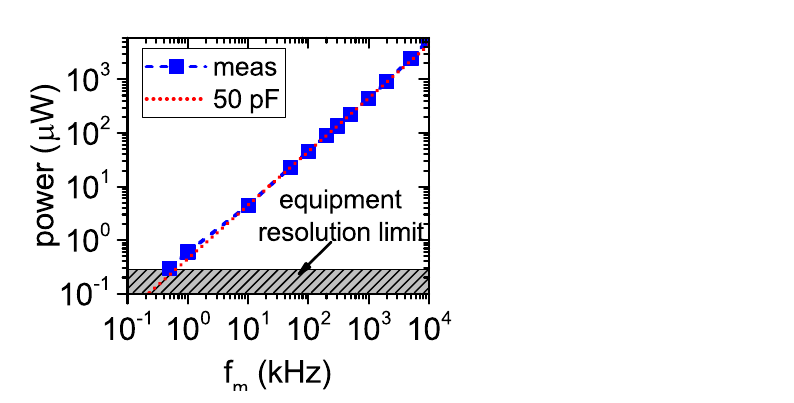
Figure 9. Dynamic power consumption of the modulator as a function of the modulation frequency. The equivalent capacitor C = 50 pF is estimated from C = P c / ( V 2 on f m ) , where V on = 3 V, with the aim to obtain the best match with the measurement results in the modulation frequency range of interest.